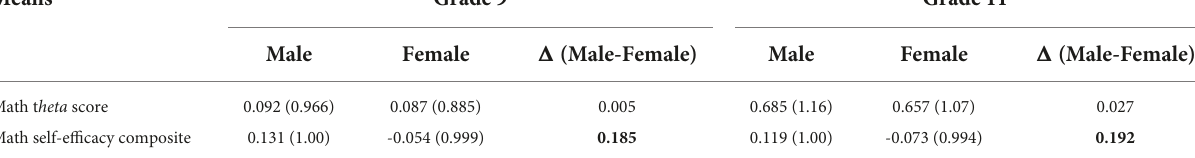
TABLE 1 Self-efficacy and mathematics achievement by gender and